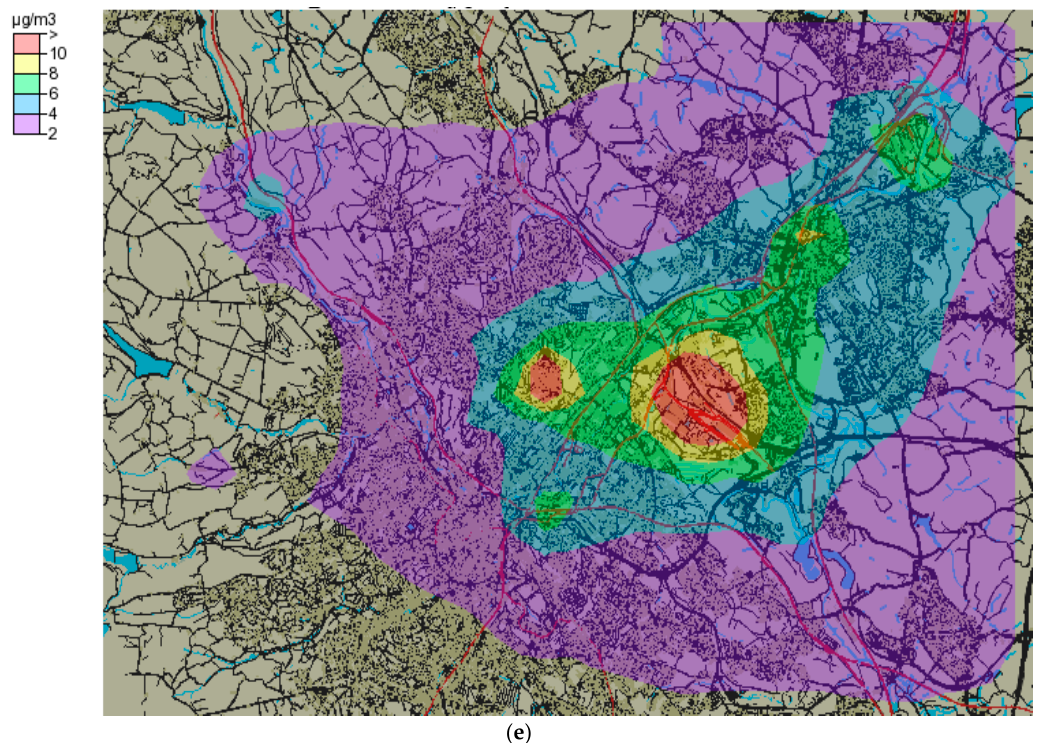
Figure 6. Estimated mean annual NOx concentrations (µg/m 3 ) using emissions from road traffic ( a ), HGV and LGV ( b ), cars both petrol and diesel ( c ), buses ( d ) and points sources ( e ) in Sheffield for the year 2017.